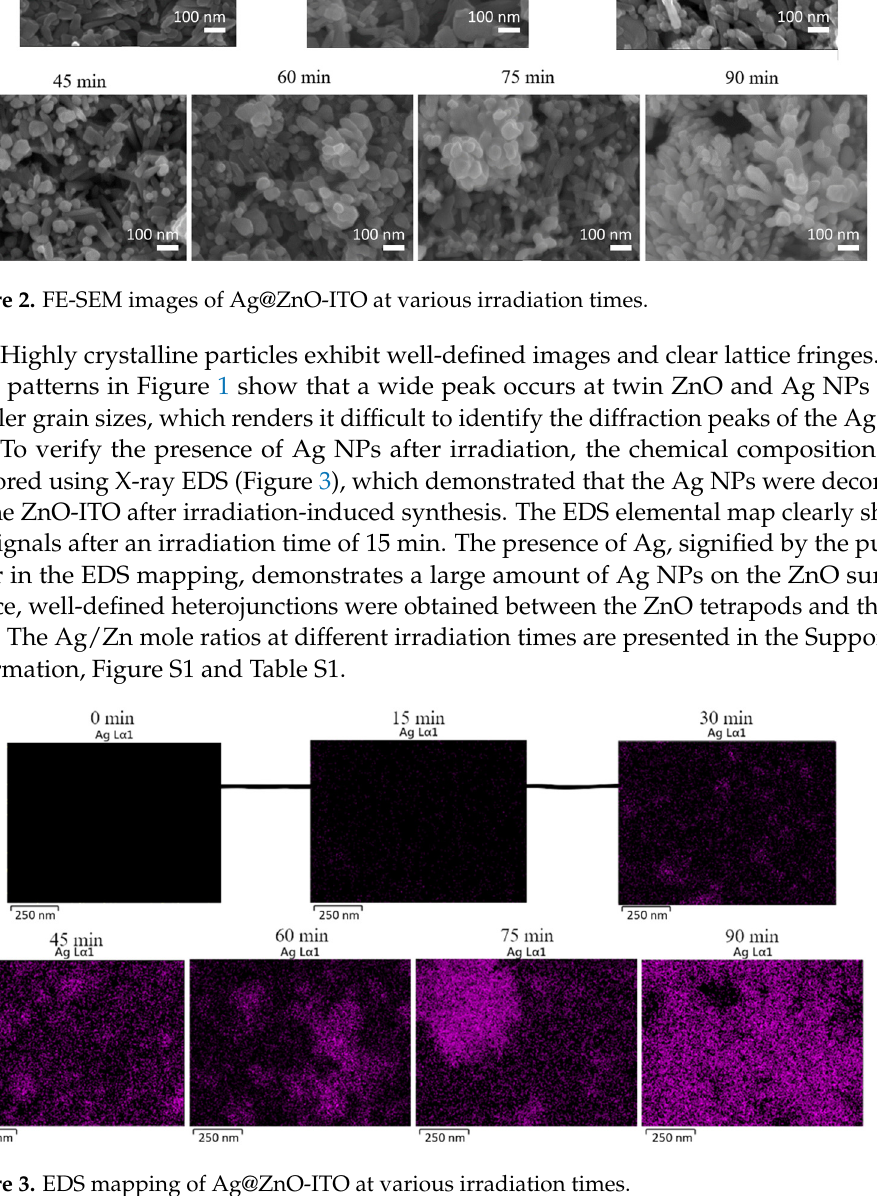
Figure 4. UV-Vis spectra of ZnO and Ag@ZnO at various irradiation times.